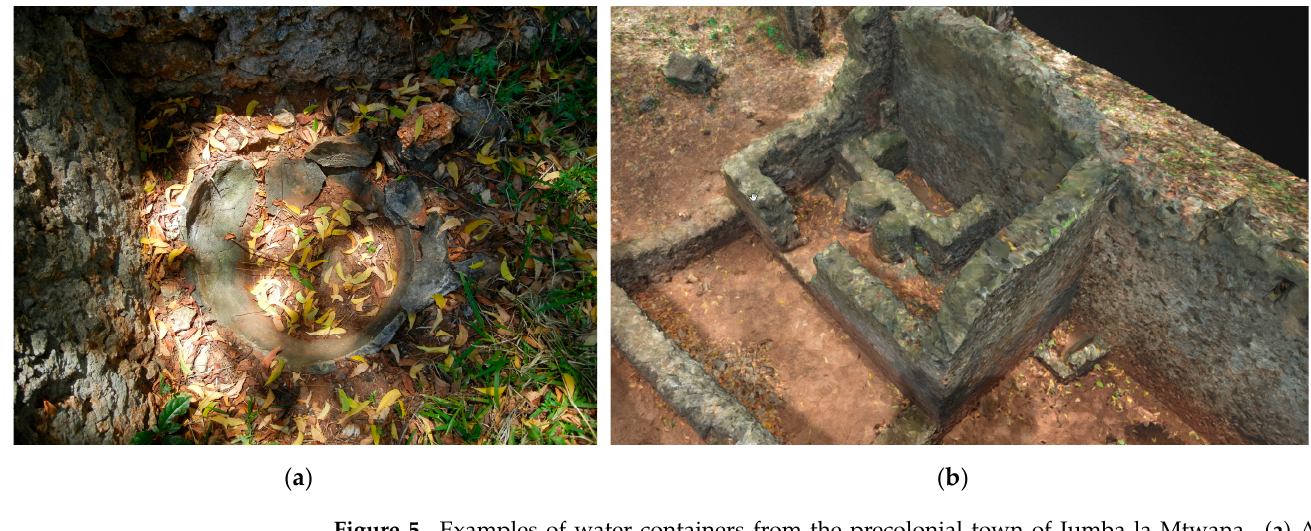
Figure 5. Examples of water containers from the precolonial town of Jumba la Mtwana. ( a ) A depression with the remainder of an inset water jar in the court of the largest house in the town, known as ‘House of Many Doors’, photo by the author, 2021; ( b ) A cistern in the so-called ‘House of the Cylinders’, which received its name after the two cylindrical seats, 3D scan processed by the Zamani 2021.